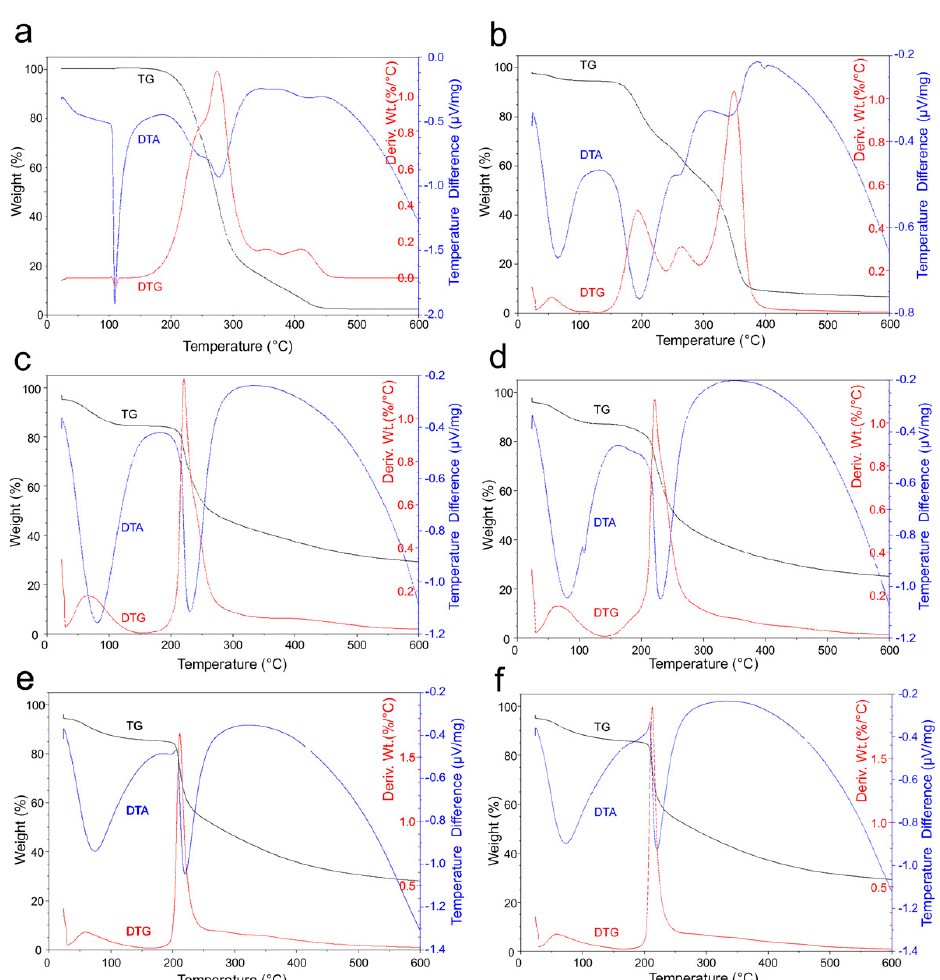
Figure 6. TG, DTG and DTA curves of: ( a ) CAT; ( b ) CAP; ( c ) CH; ( d ) Physical mixture; ( e ) NP-Cb; ( f ) NP-C.